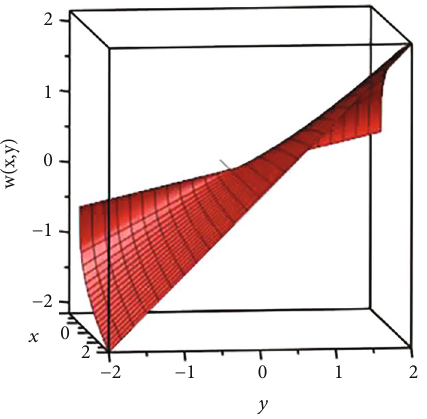
Figure 14: 3D complex plot of (59) for α = 1 and m